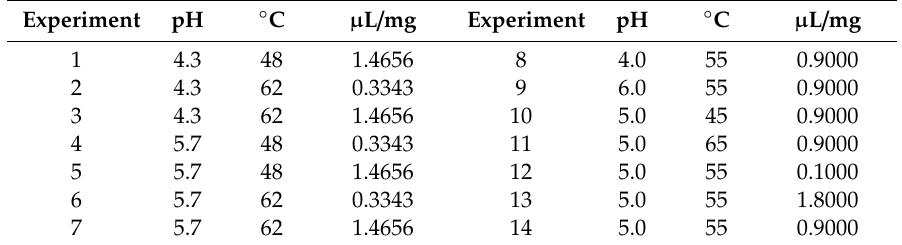
Table 1. Experimental conditions for enzyme depolymerization at micro-scale. pH stands for potential of